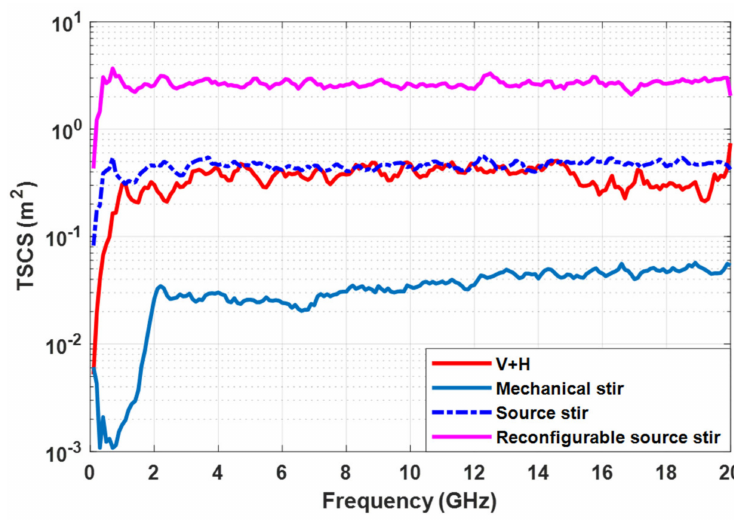
Figure 6. Measured equivalent